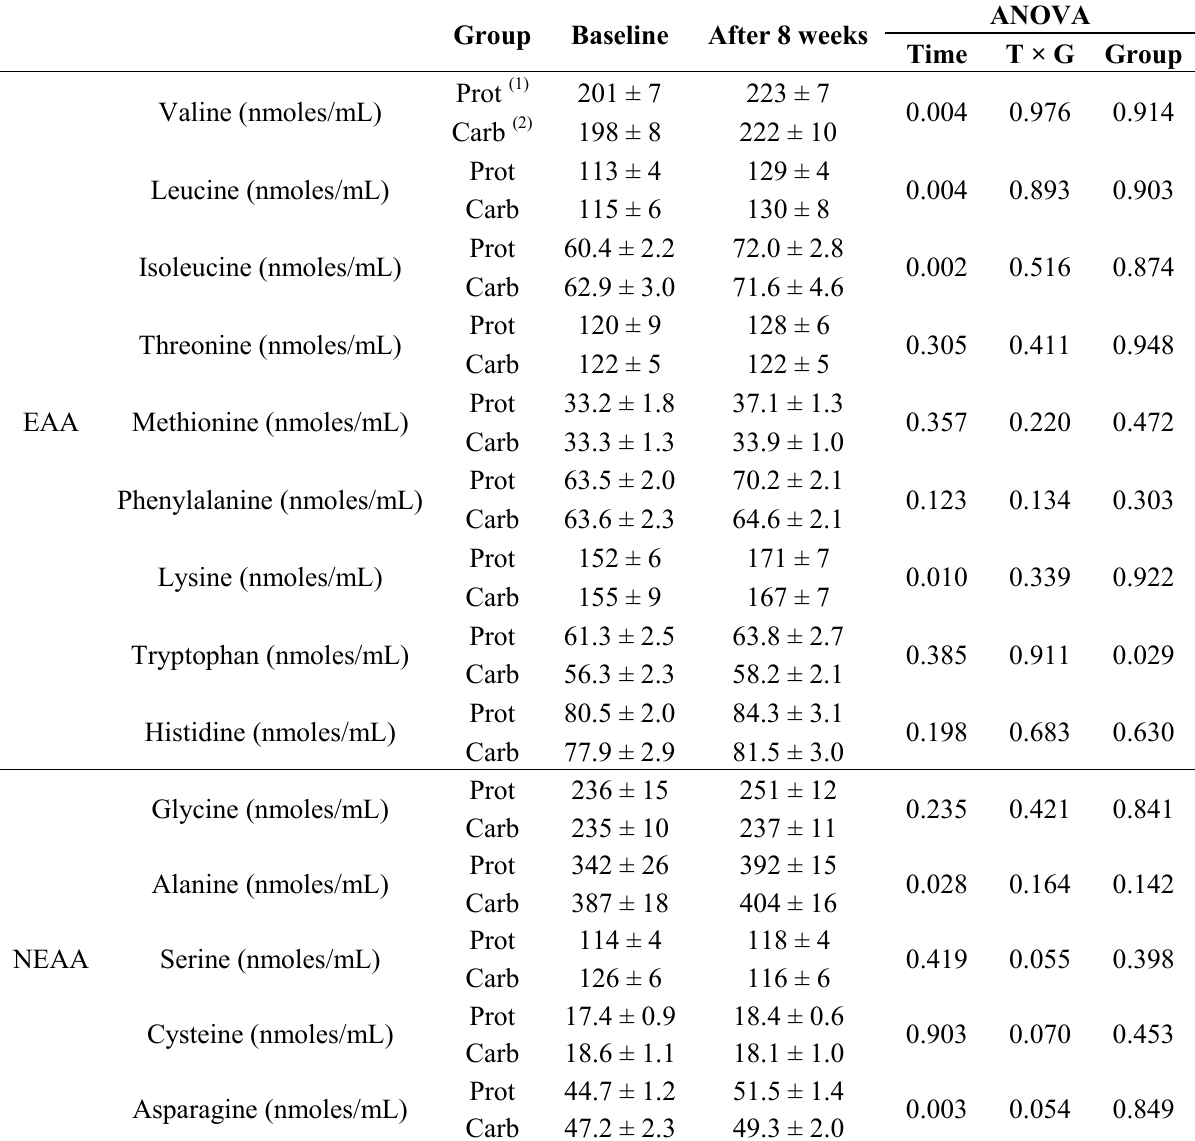
Table 4. Changes in serum free amino acid concentrations. All values are expressed as mean ± SE. EAA, essential amino acid. NEAA, non essential amino acid. BCAA, branched chain amino acid. AAA, aromatic amino acid. ANOVA, a repeated two-way analysis of variance. T × G, time × group interaction